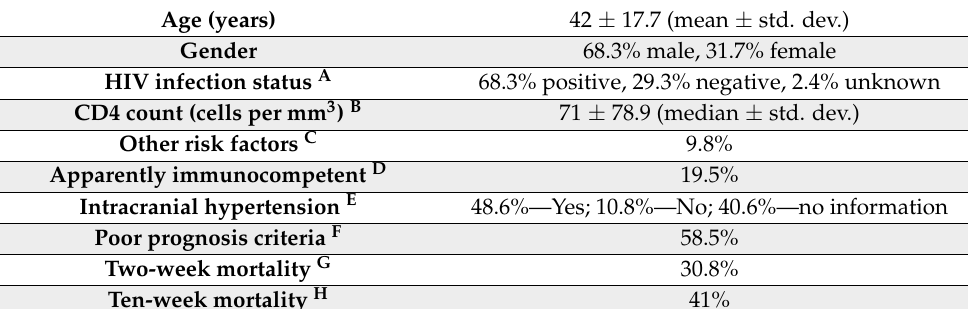
Table 1. Patient